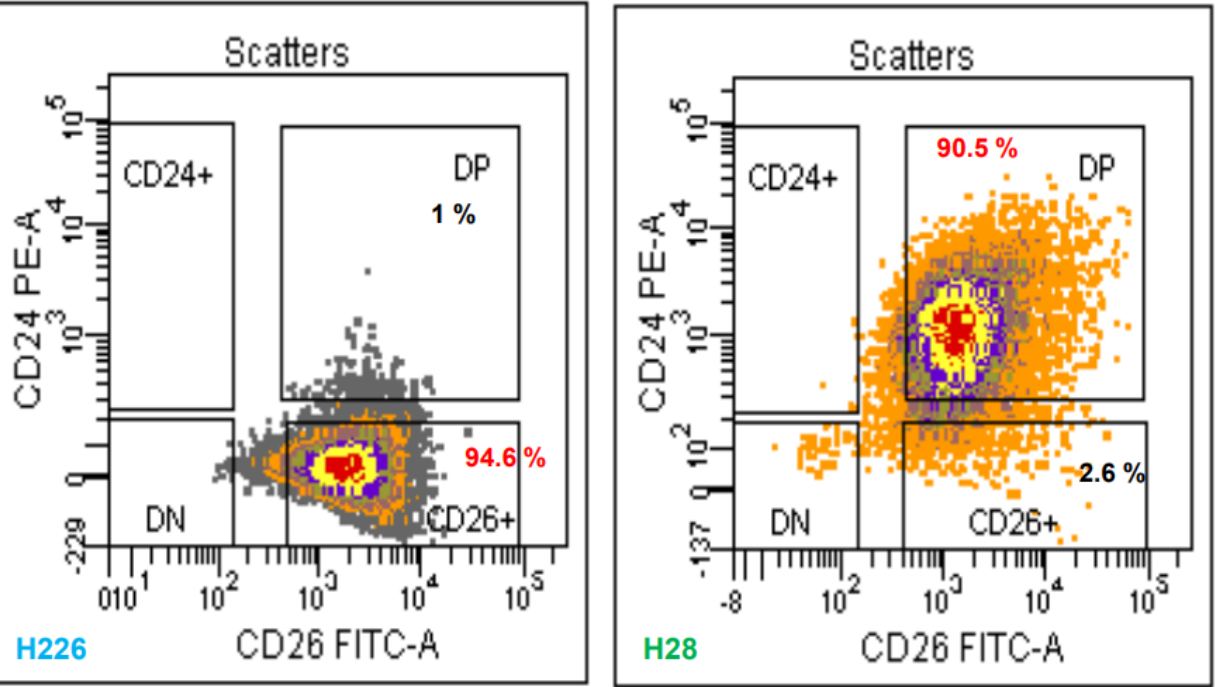
Figure 1. Phenotype expressions of mesothelioma cells, H226, H28, and MSTO-211H. Cells were trypsinized, pelleted, and resuspended in PBS containing 2% FBS. The cells were incubated with CD24-PE, CD26-FITC, and DAPI at 4 ◦ C. The double-stained population was sorted by a FACSCalibur flow cytometer.